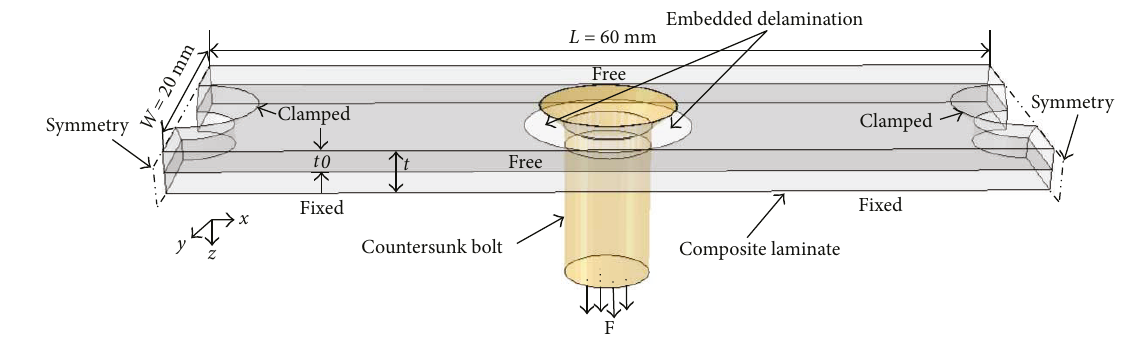
Figure 2: Simpli fi ed structural geometry, boundary condition, and applied load. Table 1: Mechanical properties of IMS194/CYCOM977-2 laminate